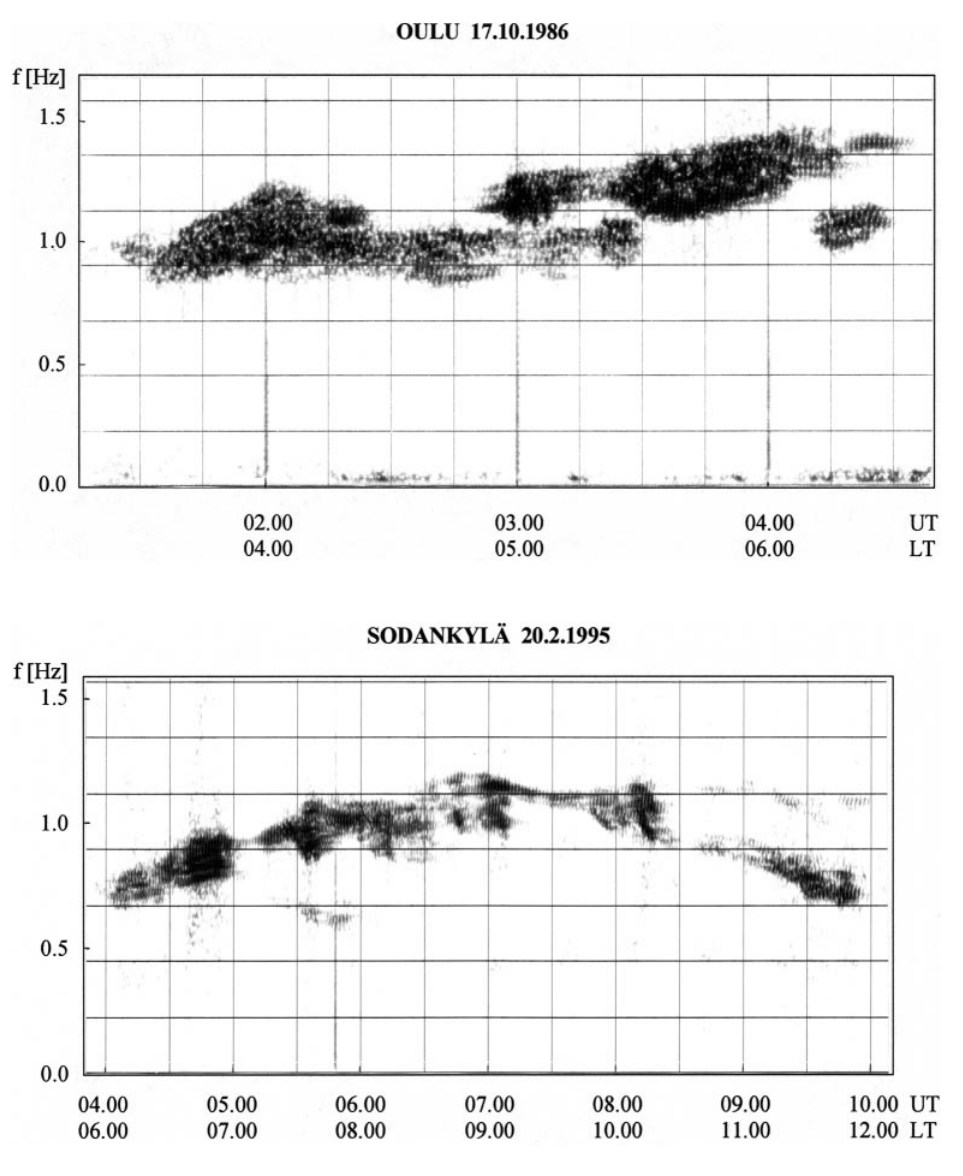
Fig. 3. The sonagram of Pc1 pulsations observed at Sod- ankyla¨ on February 20, 1995, illustrating a case when both an increase and a decrease in the central frequency appears during the same event